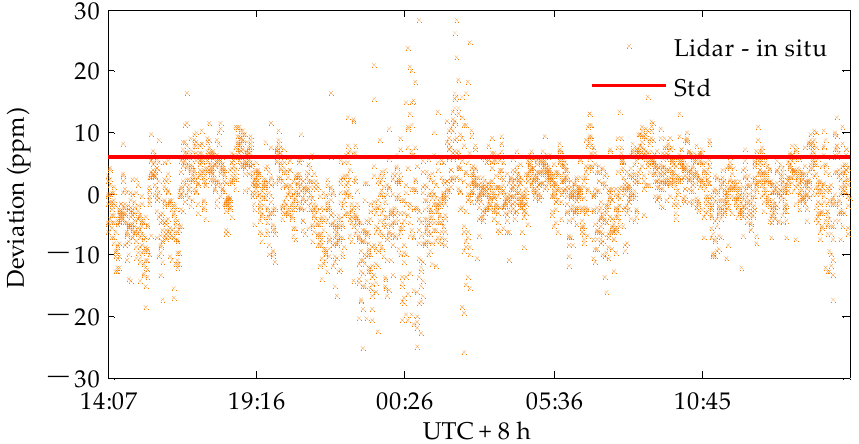
Figure 20. Simultaneous measurements of the diurnal variations of atmospheric CO 2 with the improved IPDA system and an in situ sensor. The integral path length is 1.5 km and the weather was sunny.